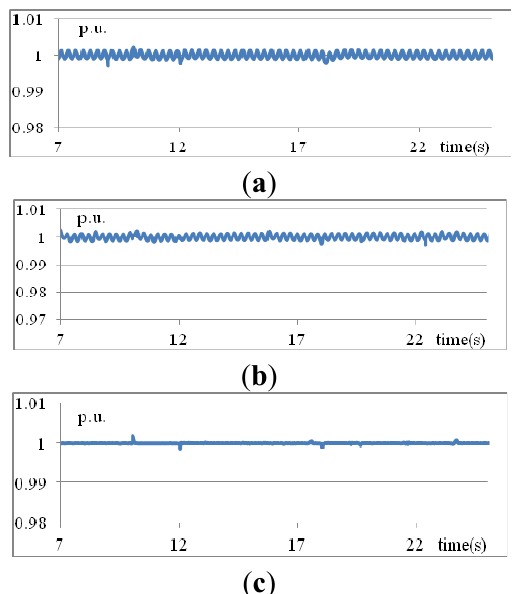
Figure 13. Voltages at bus 3 using obtained three methods: ( a ) traditional PID; ( b ) T1 fuzzy rules; ( c ) IT2 fuzzy rules (Scenario 3).